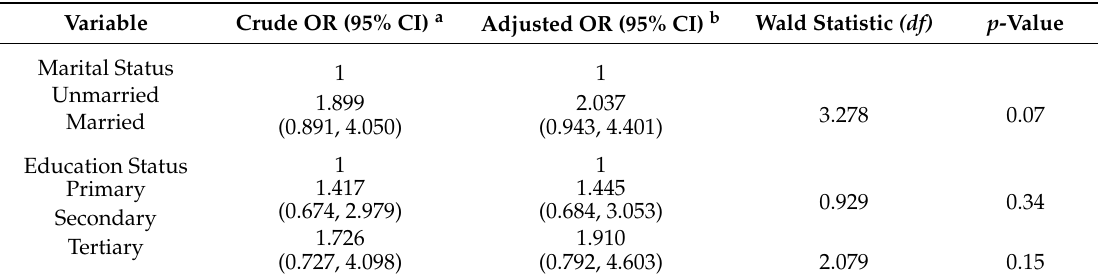
Table 3. Associated factors for good knowledge toward leptospirosis using multiple logistic regression ( N = 214).